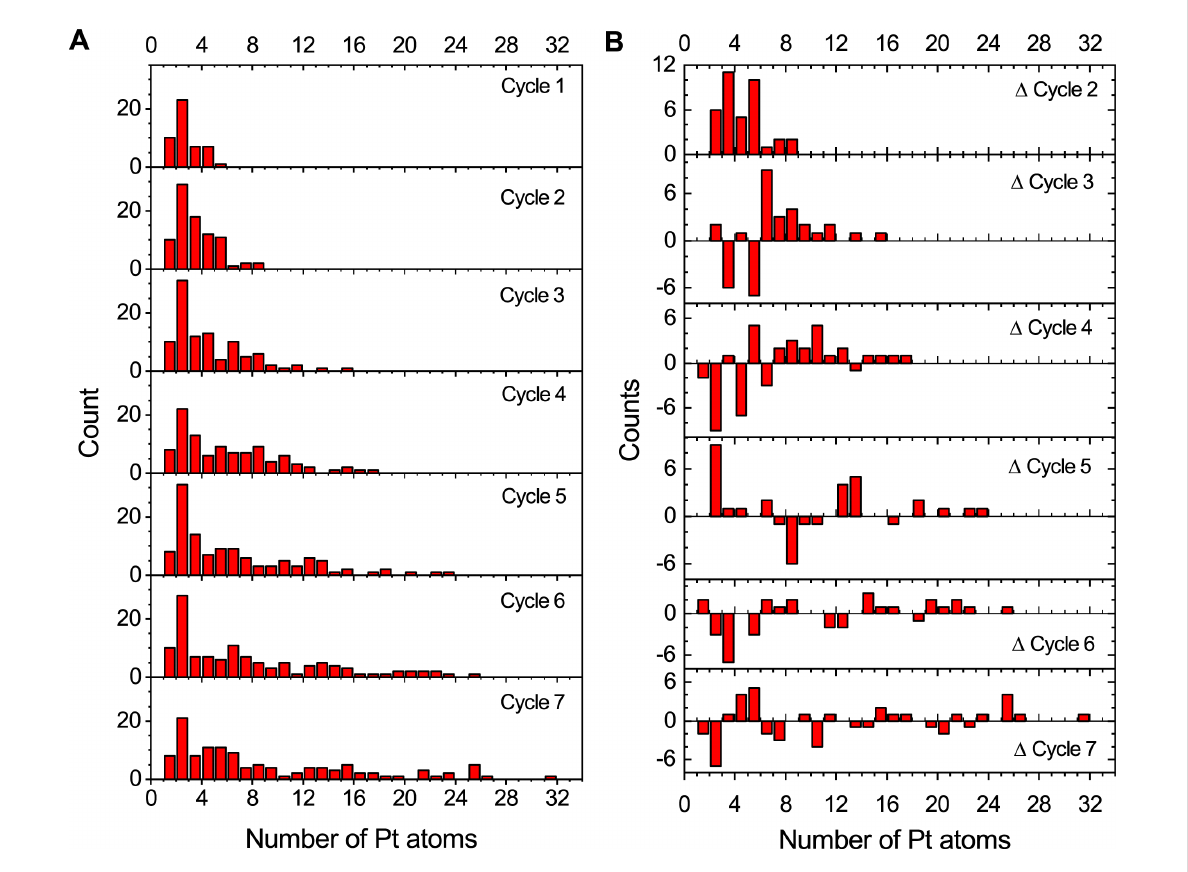
Figure 8: (A) Size distribution of Pt clusters during the first seven FEBID cycles. (B) Difference of size distributions for Pt clusters between two consecutive FEBID cycles for the first seven